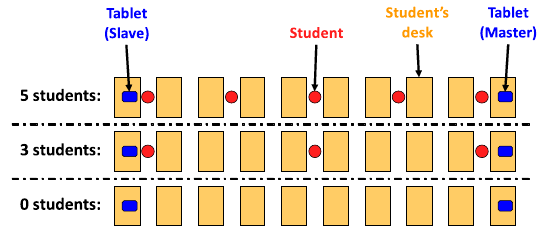
Fig. 10 Environment for survey on influence of human presence (5, 3, 0 students)